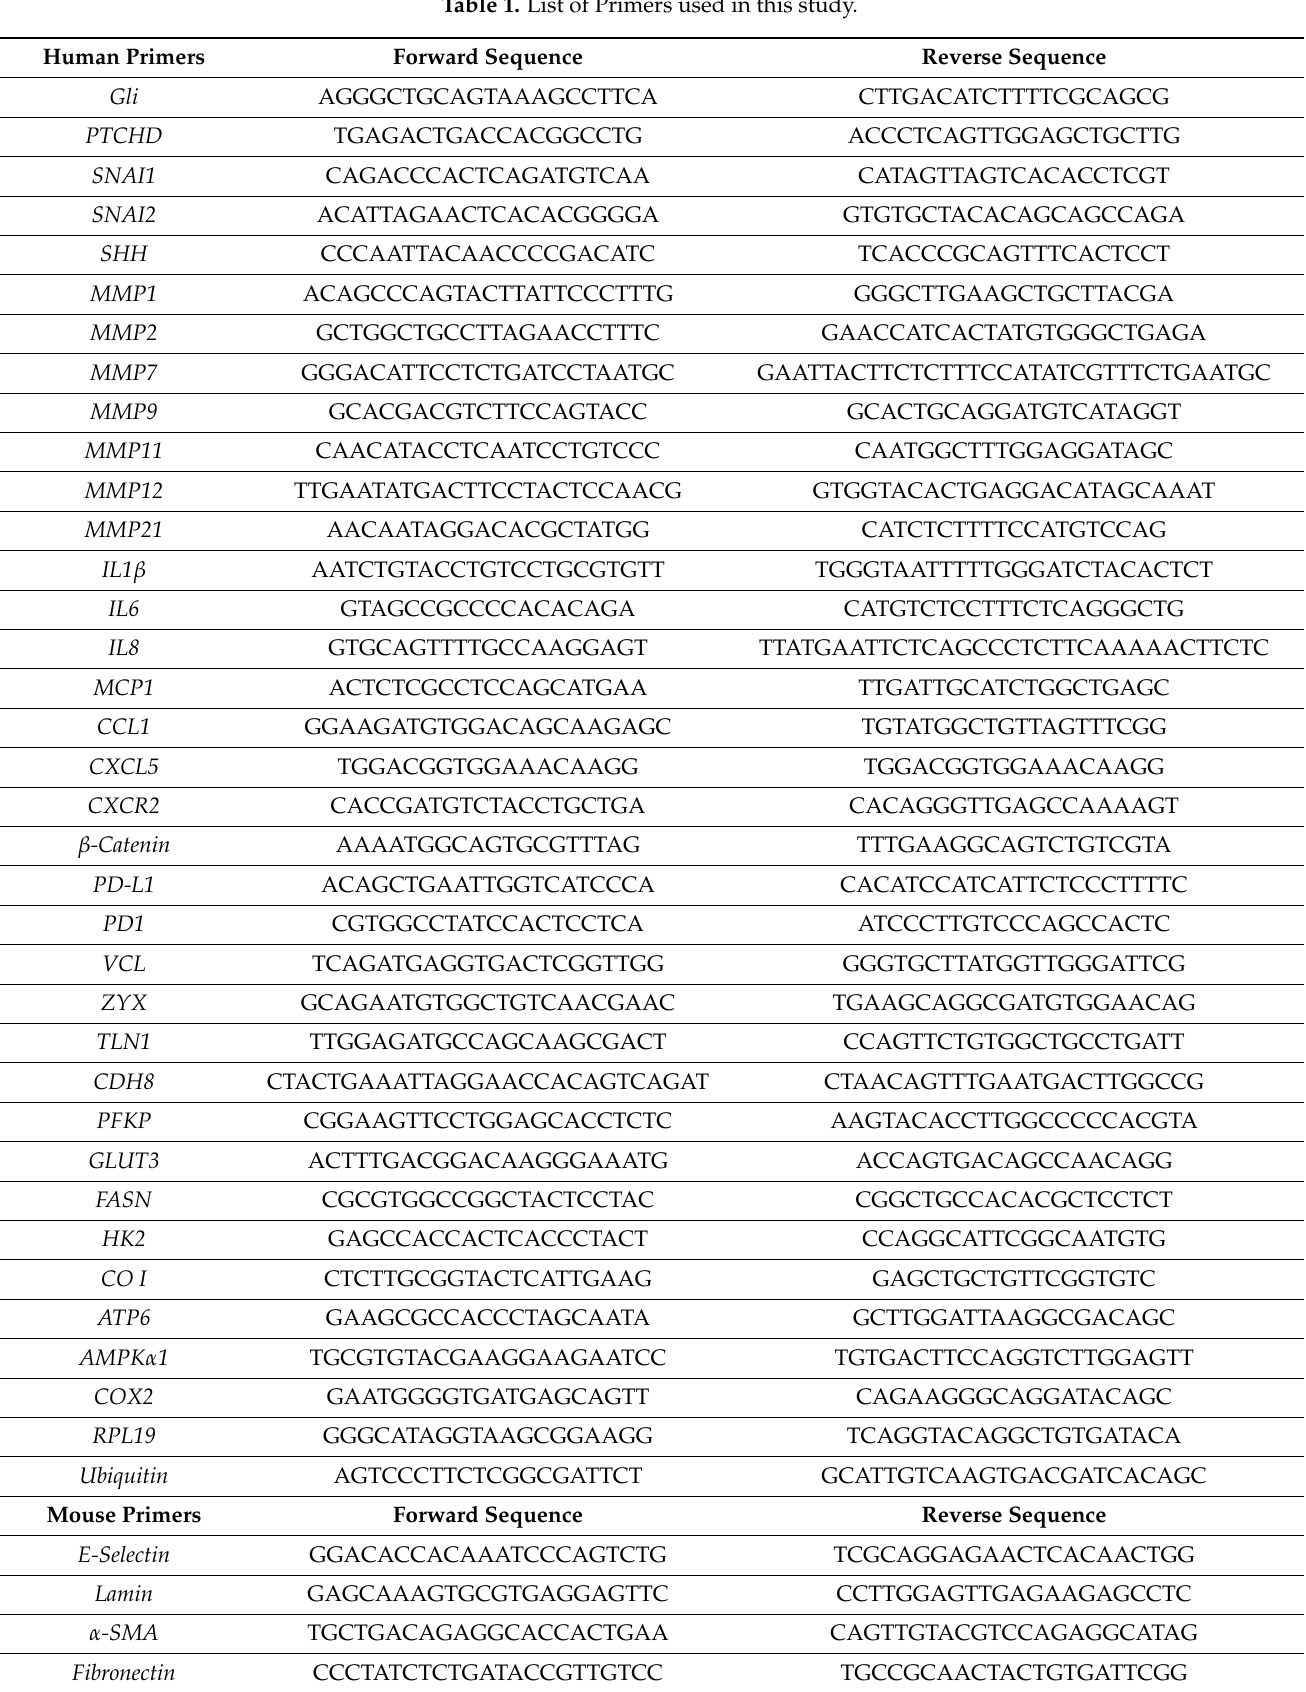
Table 1. List of Primers used in this